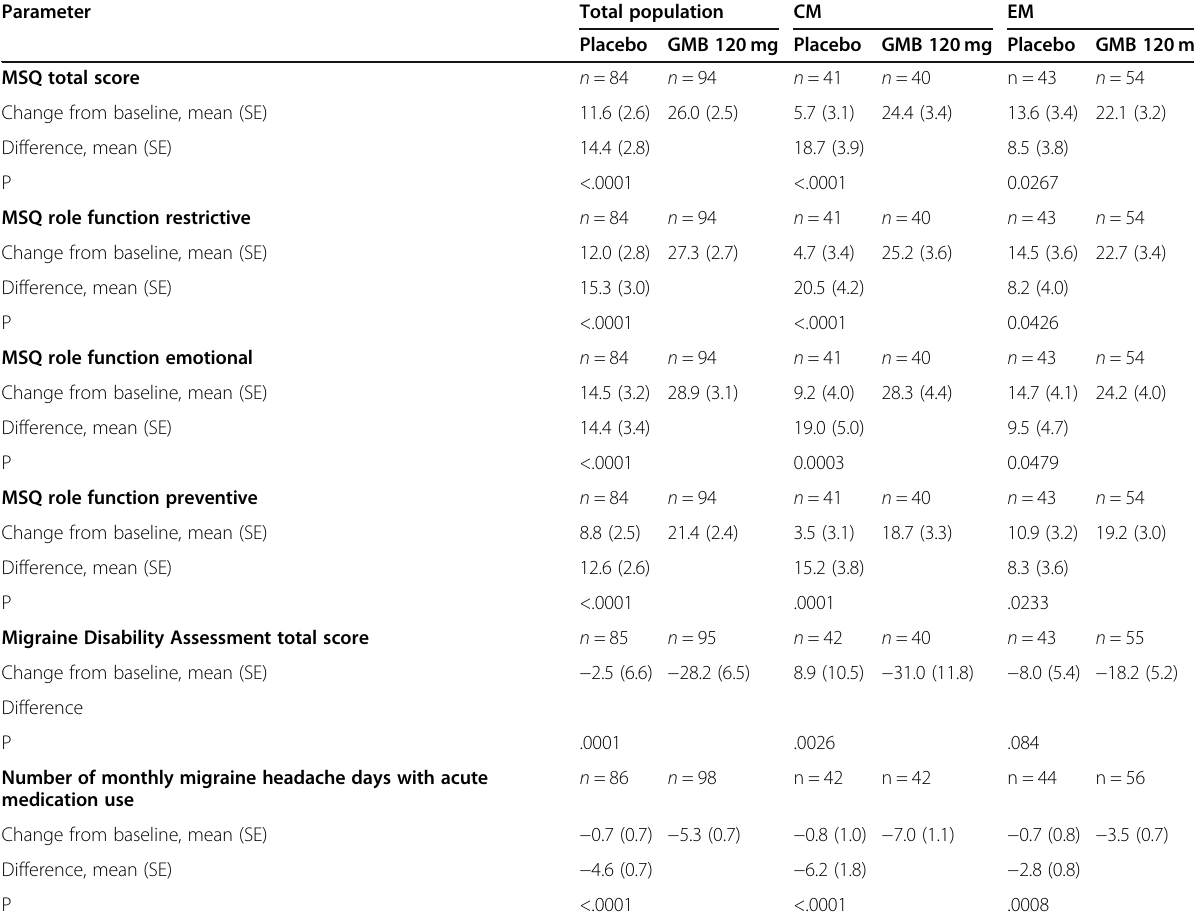
Table 2 Change from baseline in quality of life measures and number of monthly migraine headache days with acute medication use at Month 3 a